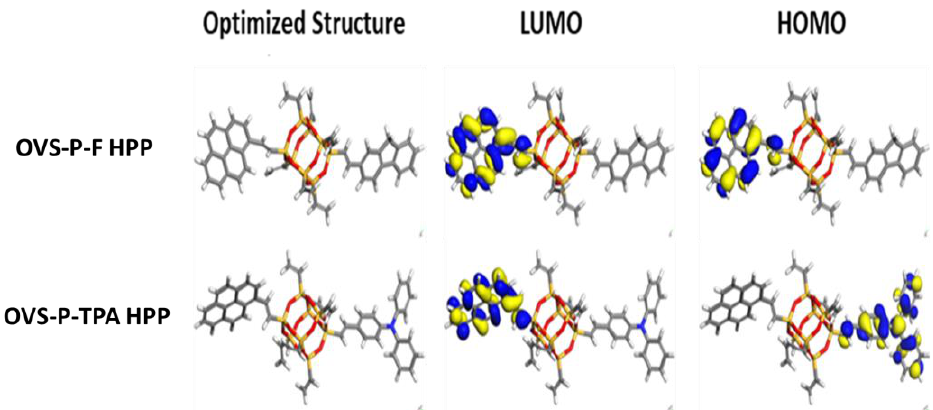
Figure 9. Optimized geometries, the density of HOMO, and the density of LUMO frontier molecular orbitals of the OVS-HPPs.